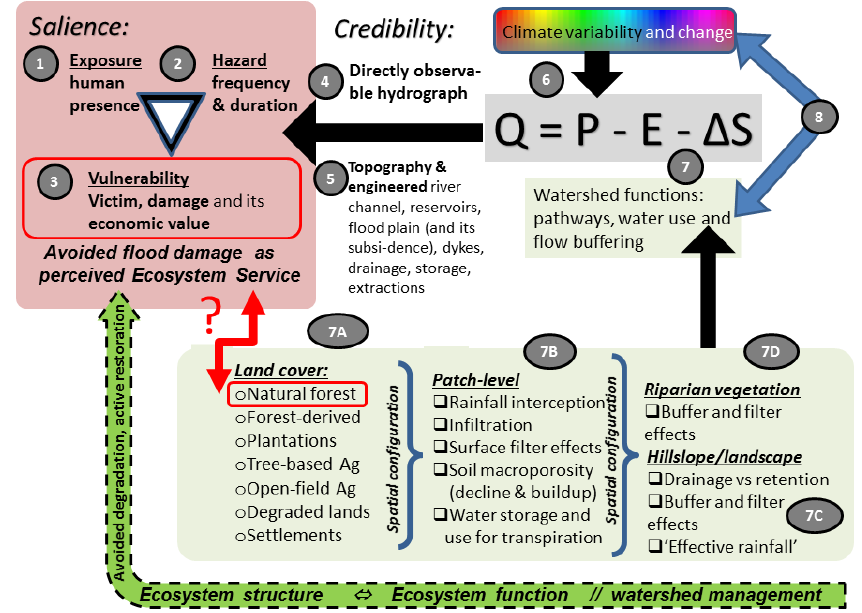
Figure 2. Steps in a causal pathway that relates the salience of “avoided flood damage as ecosystem service” to the interaction of exposure (1; being in the wrong place at critical times), hazard (2; spatially explicit flood frequency and duration) and human determinants of vulnera- bility (3); the hazard component depends, in common scientific analysis, on the pattern of river flow described in a hydrograph (4), which in turn is understood to be influenced by conditions along the river channel (5), precipitation and potential evapotranspiration ( E pot ) as climatic factors (6) and the condition in the watershed (7) determining evapotranspiration ( E act ), temporary water storage ( (cid:49)S ) and water partition- ing over overland flow and infiltration; these watershed functions in turn depend on the interaction of terrain (topography, soils, geology), vegetation and human land use; current understanding of a two-way interaction between vegetation and rainfall adds further complexity